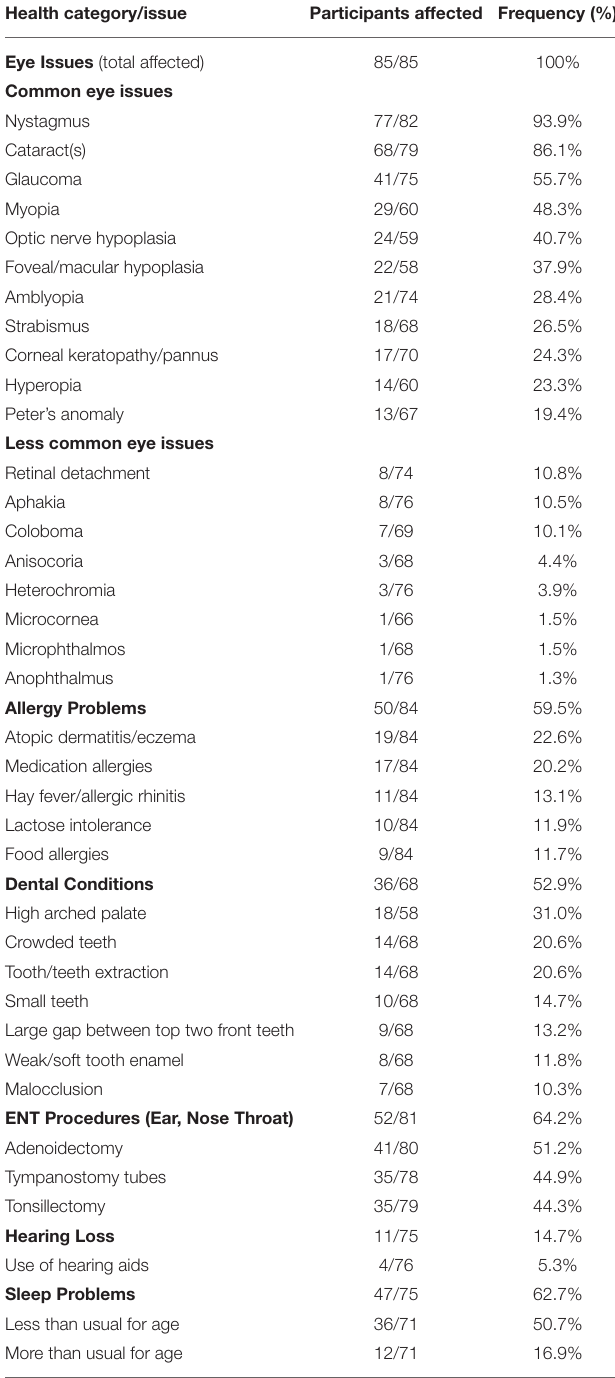
TABLE 6 | Health issues affecting the eyes, ears, nose, throat, and mouth in the WAGR discovery cohort. Health